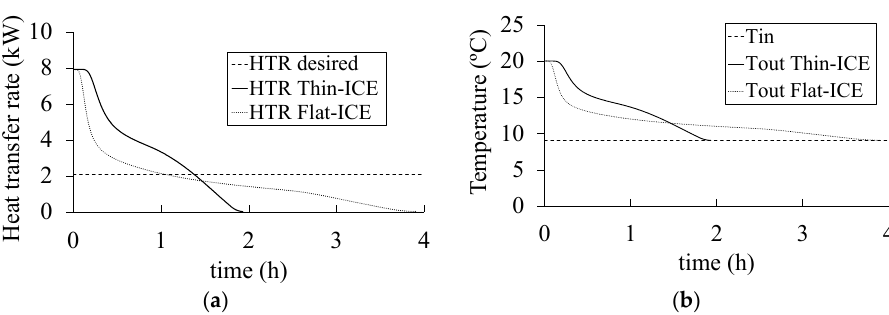
Figure 8. ( a ) Heat transfer rate and ( b ) outlet temperature of optimized Flat-ICE PCM tank during discharge and its comparison with Thin-ICE.